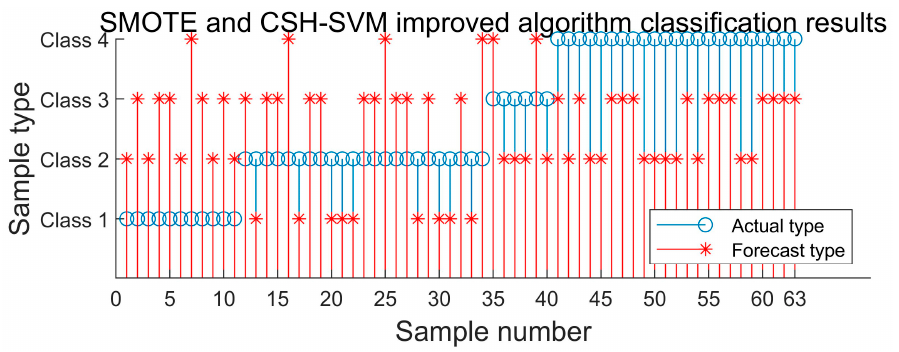
Figure 14. SMOTE and CSH-SVM improved algorithm classification